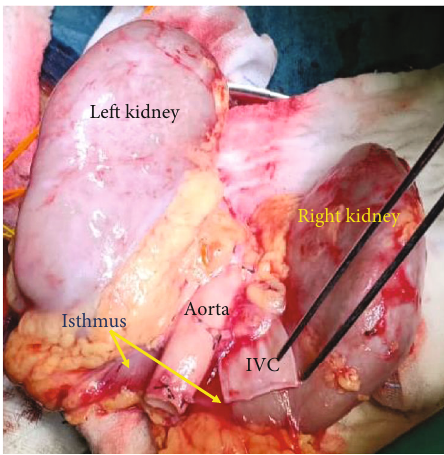
Figure 2: The posterior view of the horse kidney after procurement and completion of back table preparation, ready to be transplanted.